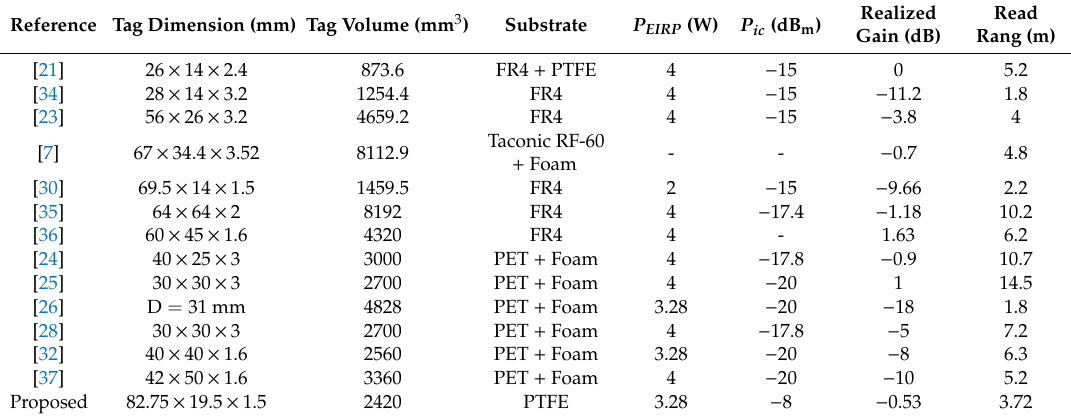
Table 1. Comparing the performance of the metallic mountable tag antennas. Reference Tag Dimension (mm) Tag Volume (mm 3